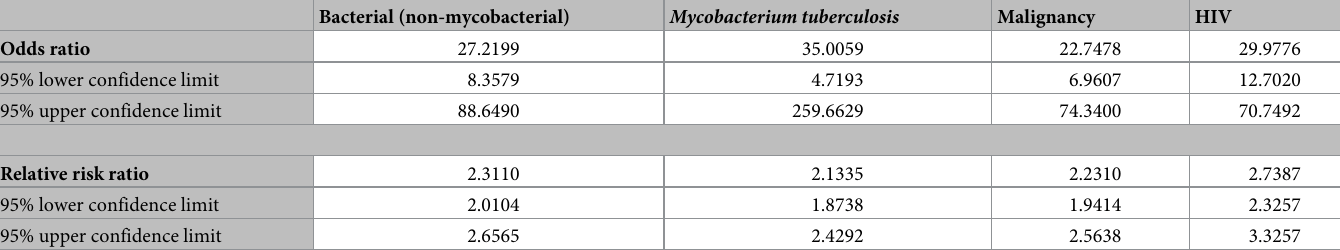
Table 5. Relative risk ratios for suspected triggers for